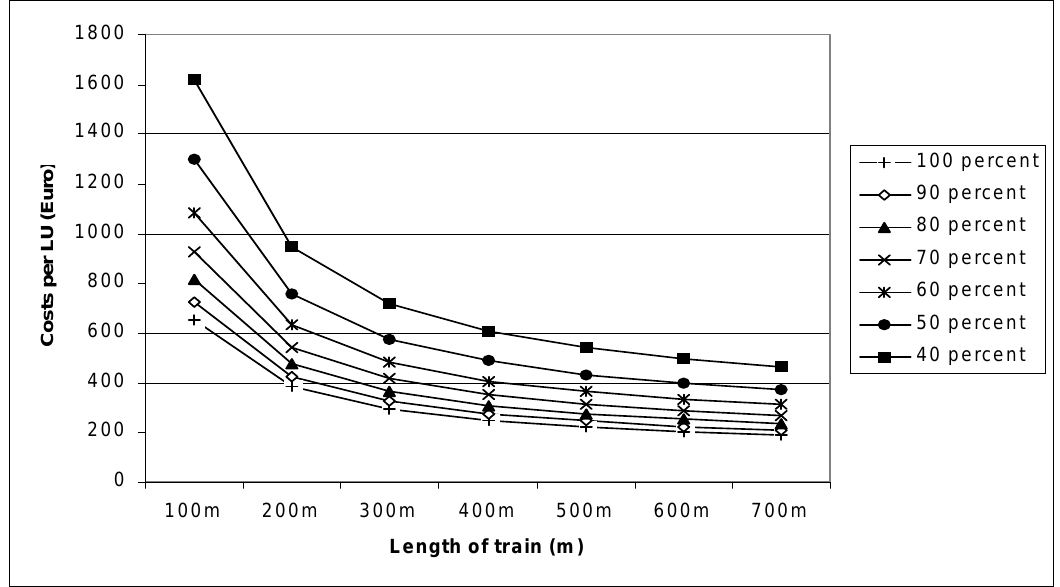
Figure 5. Train cost-price per load unit, dependent on vehicle load (Euro/LU *